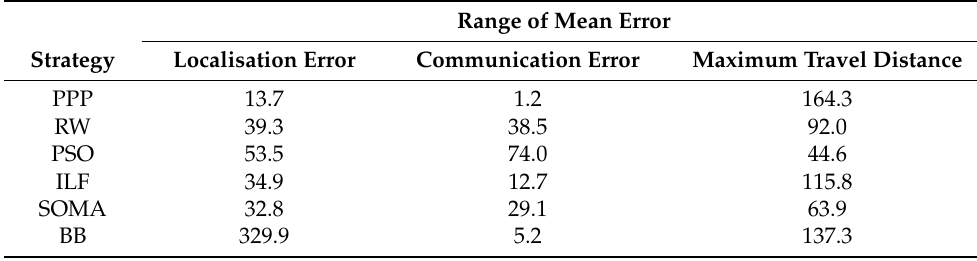
Table 4. Summarised maximum deviations of the mean error values for the six search strategies and the localisation error, communication error, and the maximum travel distance surveys.